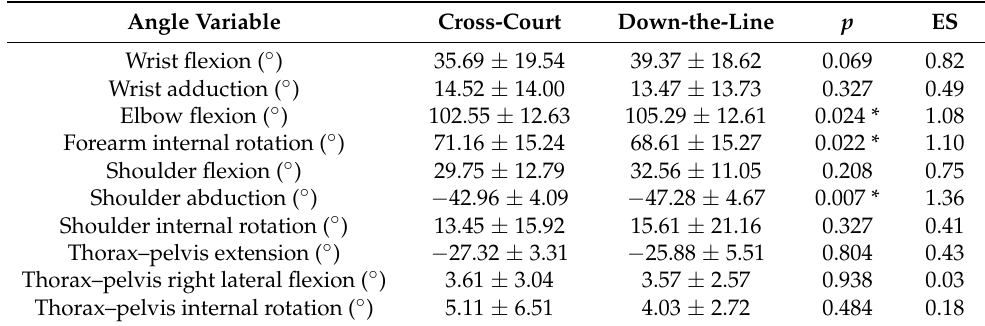
Table 1. The joint angle biomechanical variables of upper body at the moment of lowest center of gravity ( n = 8).